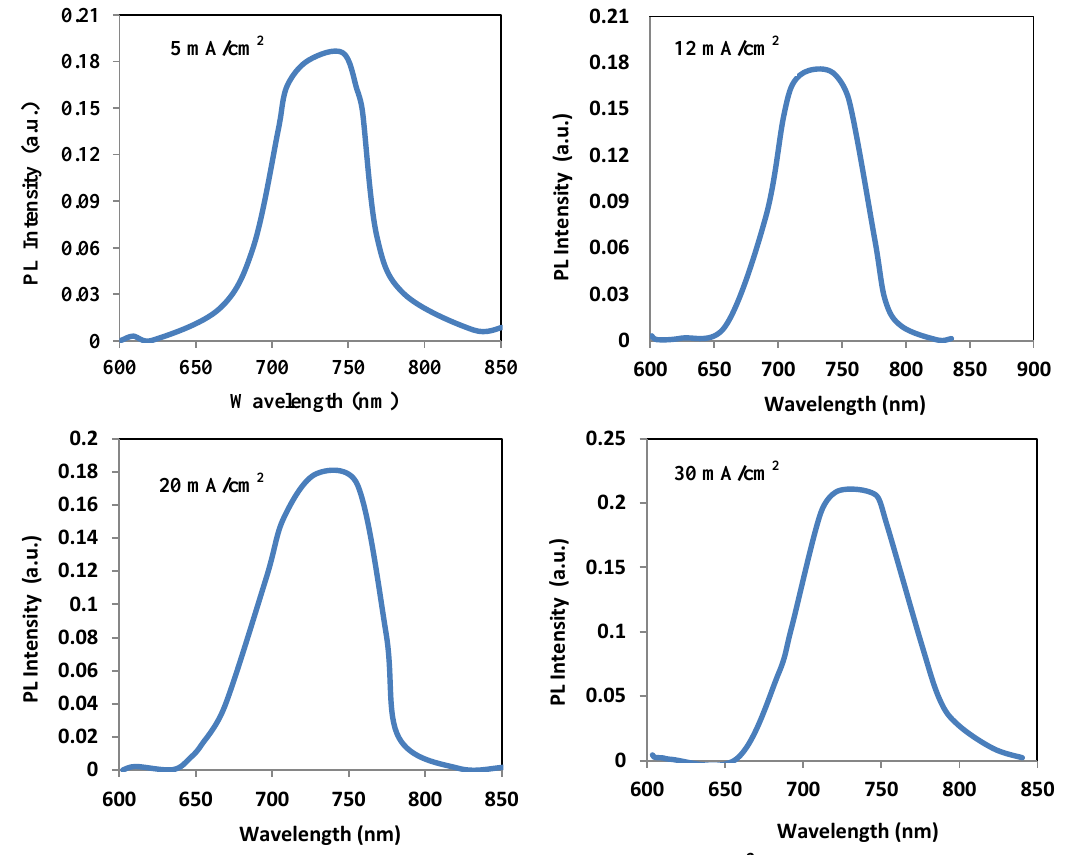
Fig. 5: PL spectra for PS prepared at J =5, 12, 20 and 30 mA/cm 2 , etching time was 15 min and the HF concentration was